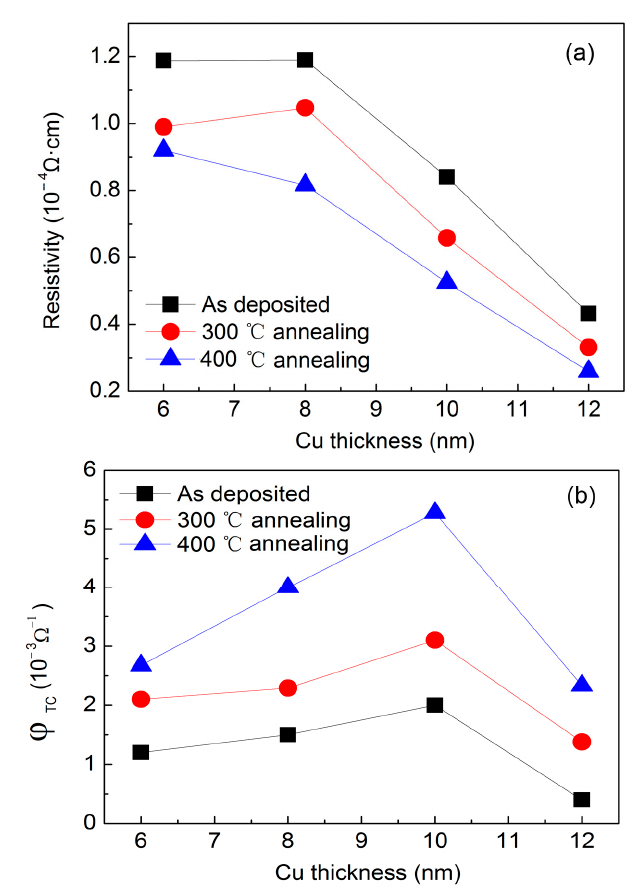
Figure 2. ( a ) Resistivity of multilayers and ( b ) figure of merit (FOM) as a function of Cu thickness.